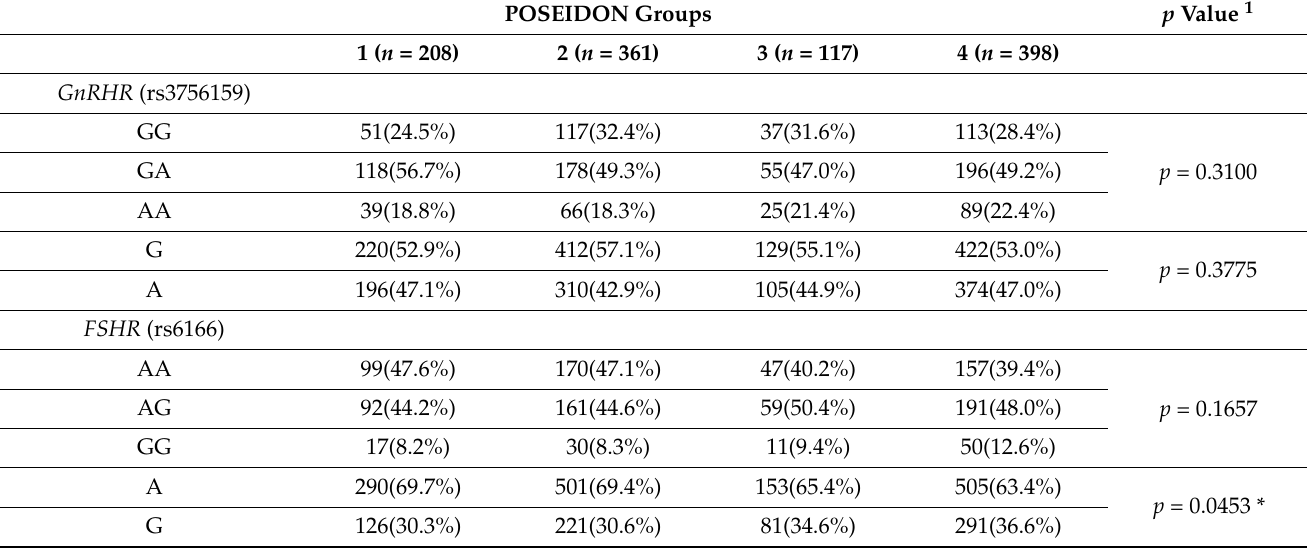
Table 2. Distribution of SNP polymorphism in POSEIDON groups ( n =